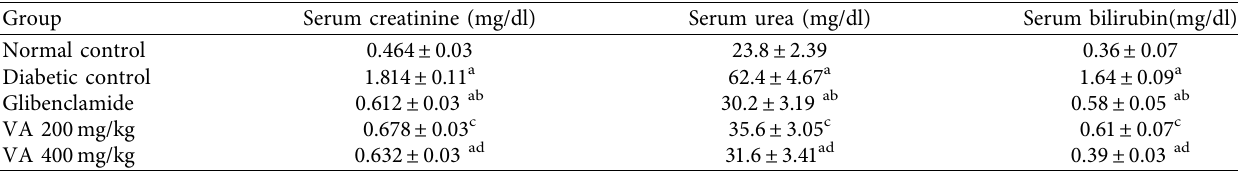
Table 4: Protective effect of V . album extract on kidney functions.